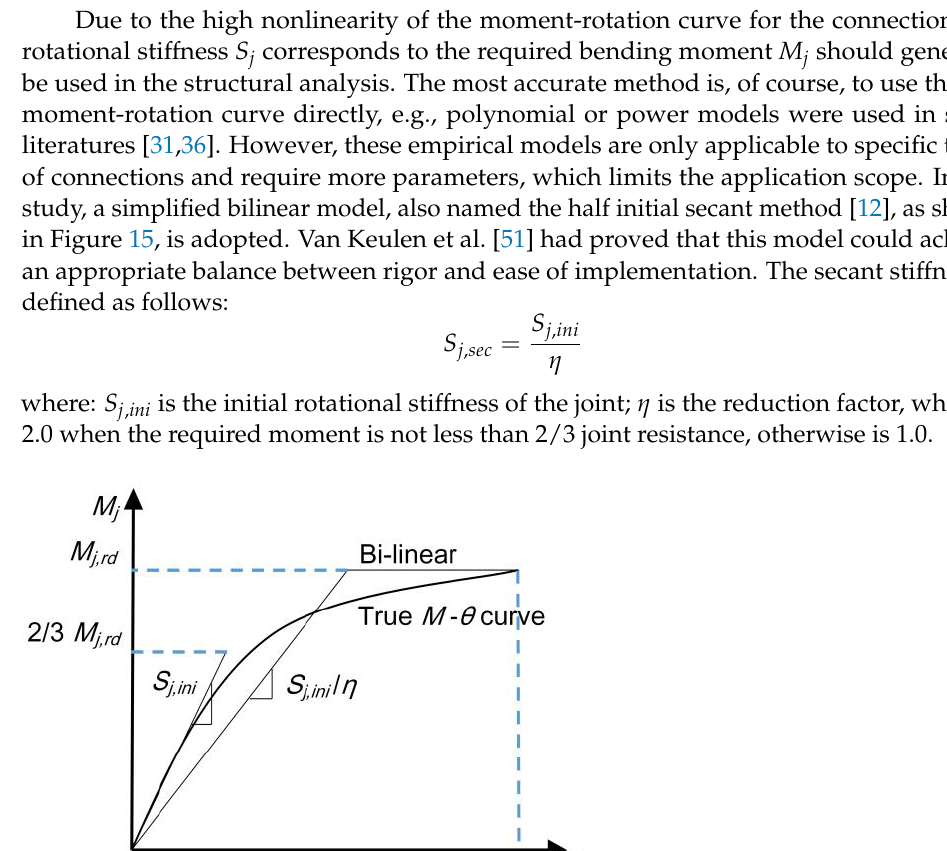
Linear spring. ( d )